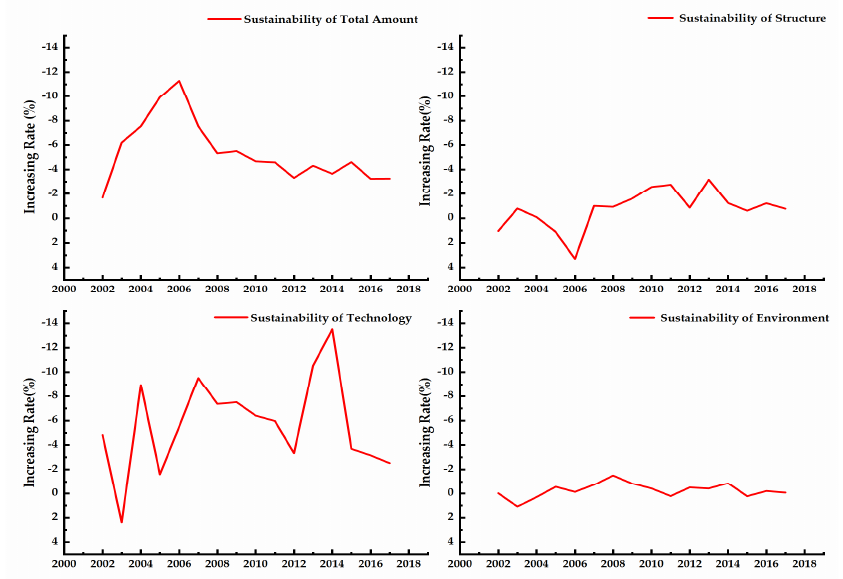
Figure 12. Changes in the sustainability of the element layers of China’s power supply and demand